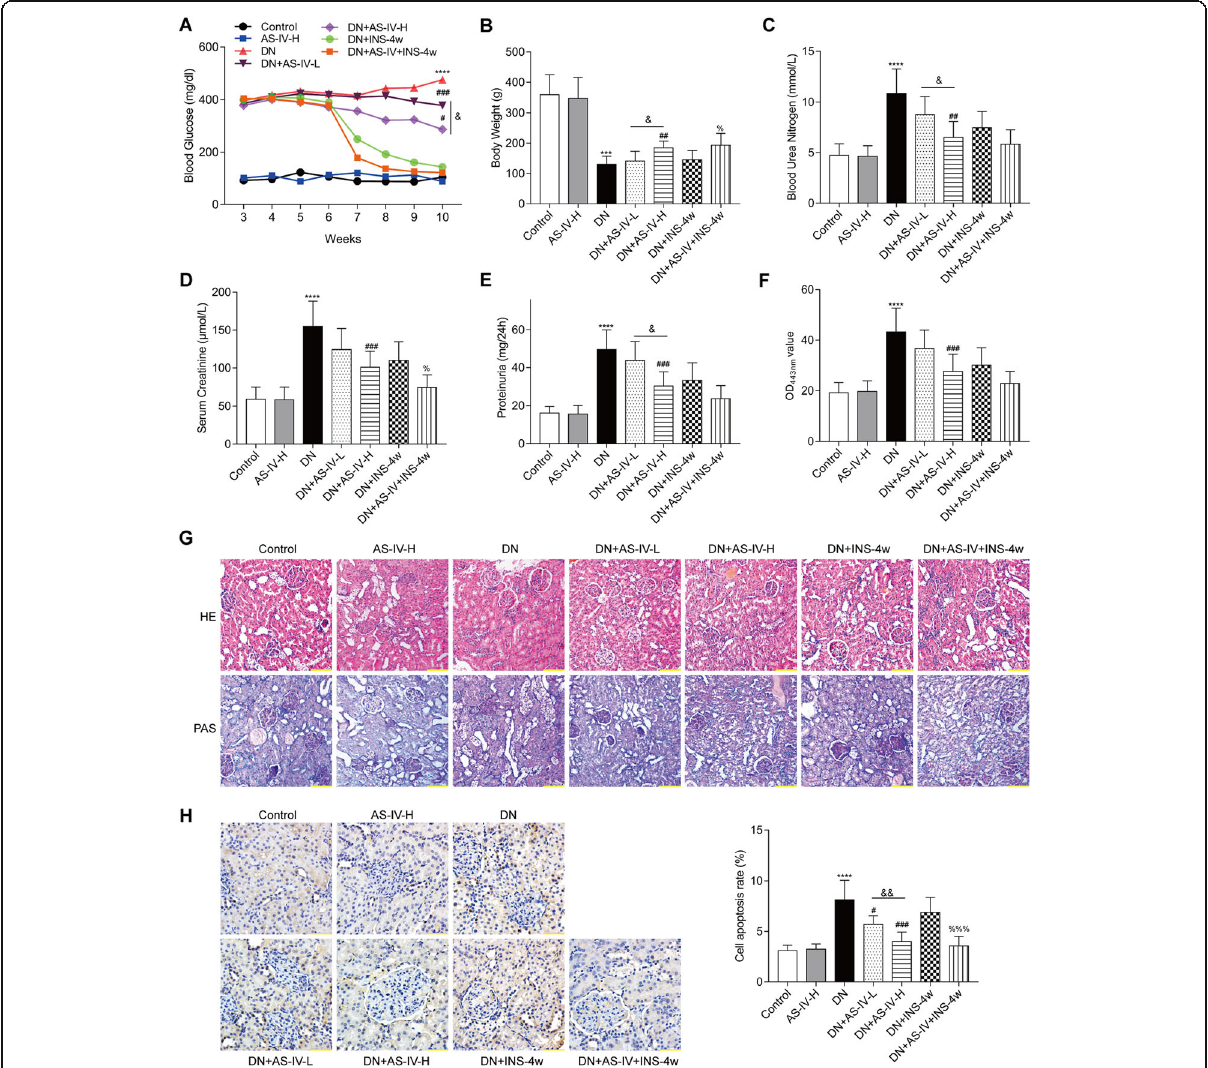
Fig. 2 Effects of AS-IV on metabolic parameters in kidney damage rats. a Fasting blood glucose was recorded every week after injecting STZ two weeks. b Body weight ( b ), Blood urea nitrogen ( c ), Scr serum creatinine ( d ), proteinuria ( e ), HbA1c ( f ) of rats was measured at the end of the study. g Kidney sections from each group of rats were detected by HE and PAS staining, bar = 100 μ m. H Representative images of TUNEL staining, bar = 50 μ m. Data are expressed as mean ± SD ( n = 6). **** p < 0.0001, *** p < 0.001 vs. control; ### p < 0.001 vs. DN, ## p < 0.01; % p < 0.05 vs DN + ING-4w. && p < 0.01, & p <